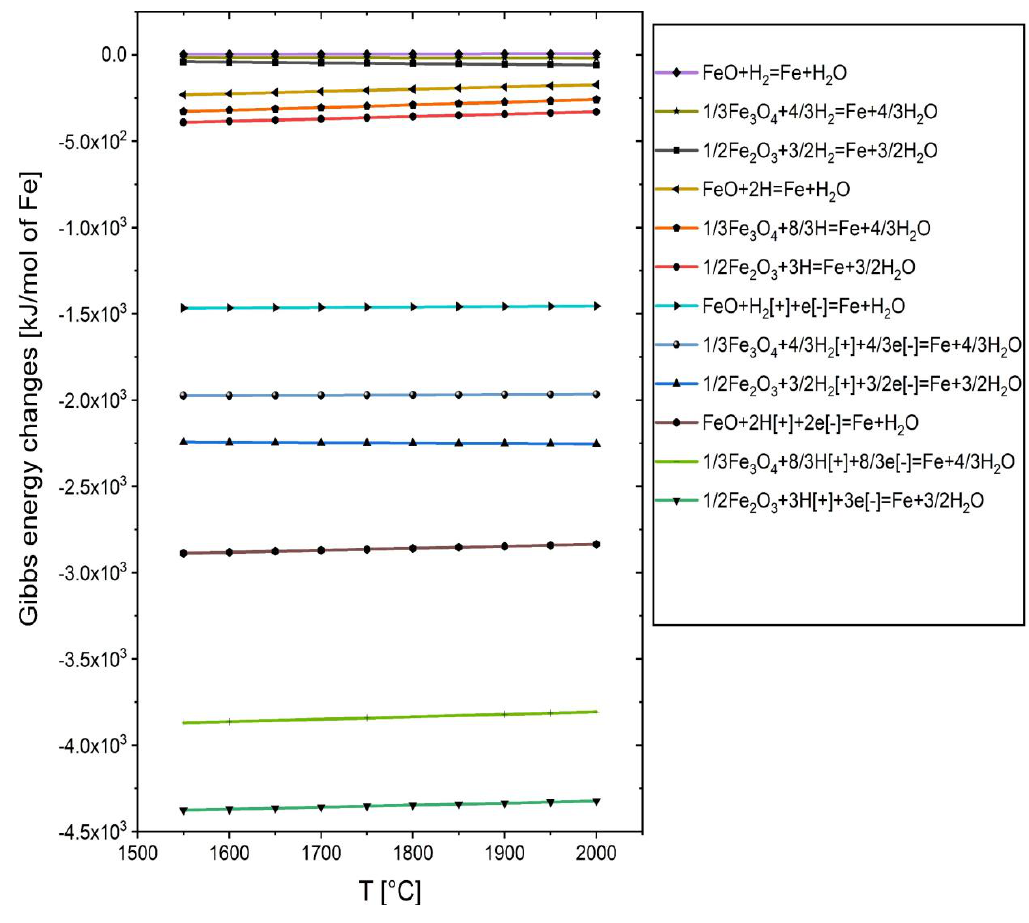
Figure 2. ΔG°–T curve for the reduction of iron oxides with different chemically active hydrogen species calculated using FactSage™ 7.1 (Database: FactPS 2017).